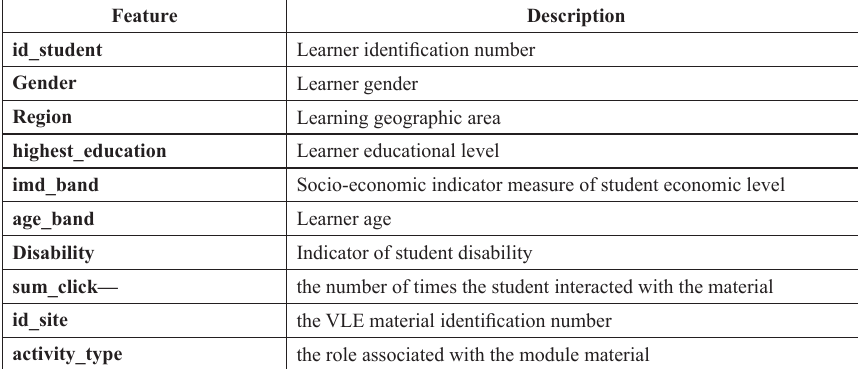
Table 2. OULAD dataset